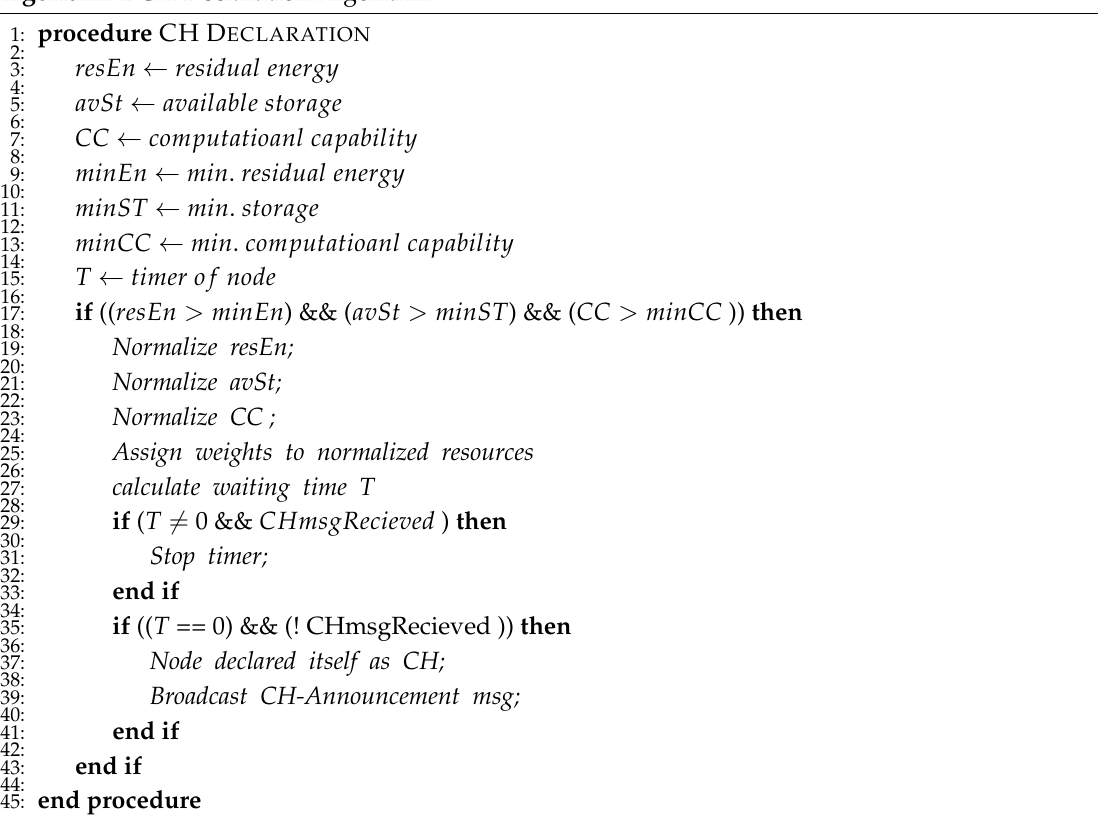
Algorithm 1 CH Declaration